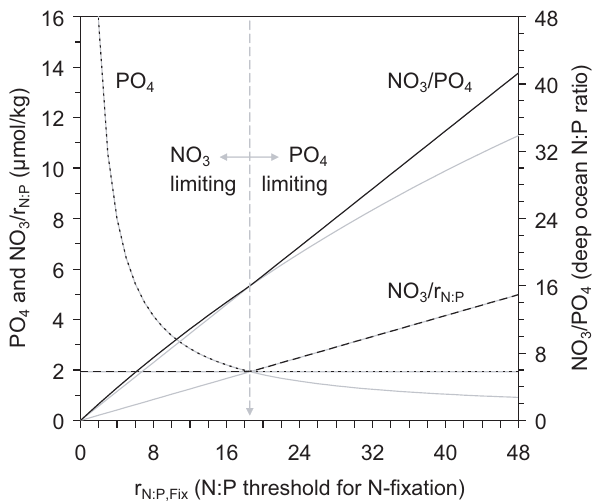
Fig. 3. Analytic solutions for the dependence of steady state PO 4 (dotted line), NO 3 / r N : P (dashed line), and deep ocean N:P ratio (solid line) on the N:P threshold for N 2 -fixation ( r N : P , Fix ), in the LW model. Here the N:P Redfield ratio (i.e. the composition of all phytoplankton) is fixed at r N : P =16. We plot NO 3 / r N : P rather than NO 3 to visually indicate whether PO 4 or NO 3 is limiting. The pale grey solid lines show the solutions for both NO 3 limiting and PO 4 limiting conditions throughout. However, for a given value of r N : P , Fix , only one set of solutions is valid and self-consistent. The space divides into two regimes, one where NO 3 is limiting and the other where PO 4 is limiting (when r N : P , Fix ≥ 18 .